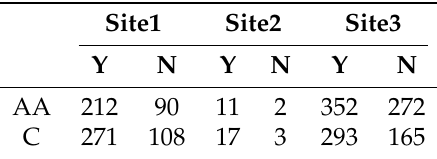
Table 5. Number of subjects virally suppressed (Y) and not suppressed (N) stratified by race (AA = African-American, C = Caucasian) and site.